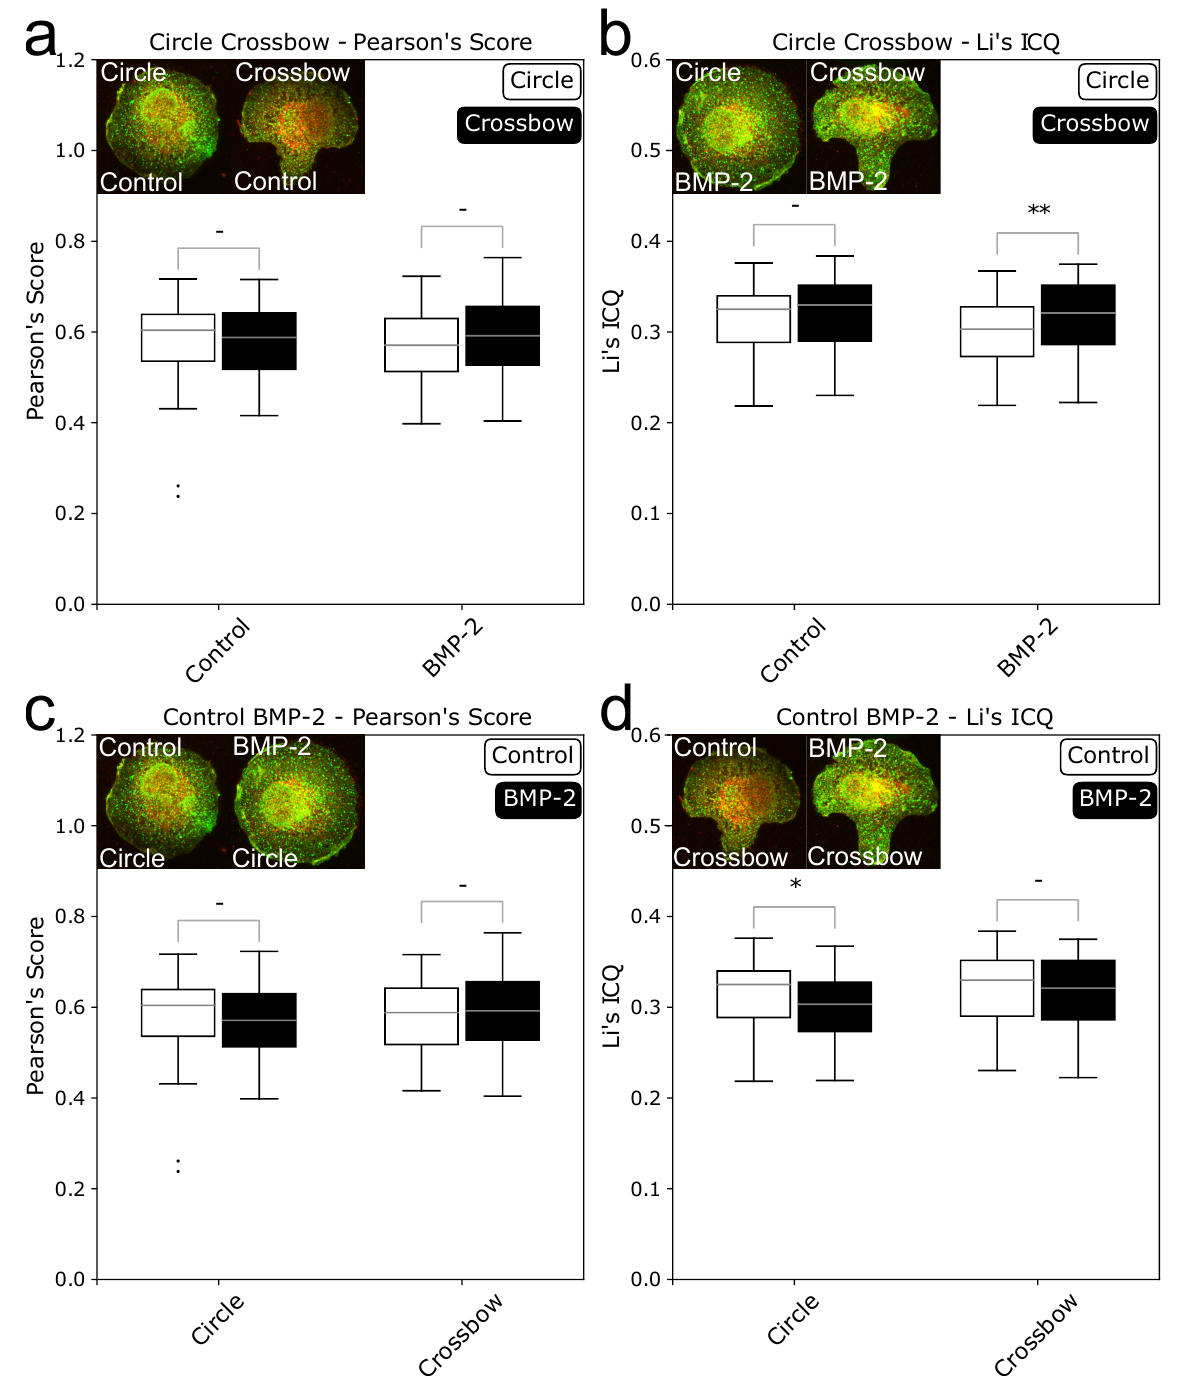
Figure 6. Boxplots of colocalization values of BMPRIb and BMPRII in HUVECs. ( a , b ): colocalization values of circle and crossbow cells +/ − BMP-2, using Pearson’s score ( a ) and Li’s ICQ ( b ). c and d: colocalization values of control and BMP-2 induced cells in circle and crossbow cells, using Pearson’s score ( c ) and Li’s ICQ ( d ). Confocal images of HUVECs on circle- and crossbow-patterns were analyzed with the JaCoP imageJ extension [20]. Changes in colocalization between induced an noninduced cells indicated that the BMP-induced signaling complex is preferably used. No change in colocalization suggested that preformed complex is predominantly used. * = p < 0.05, ** = p < 0.01, - = not